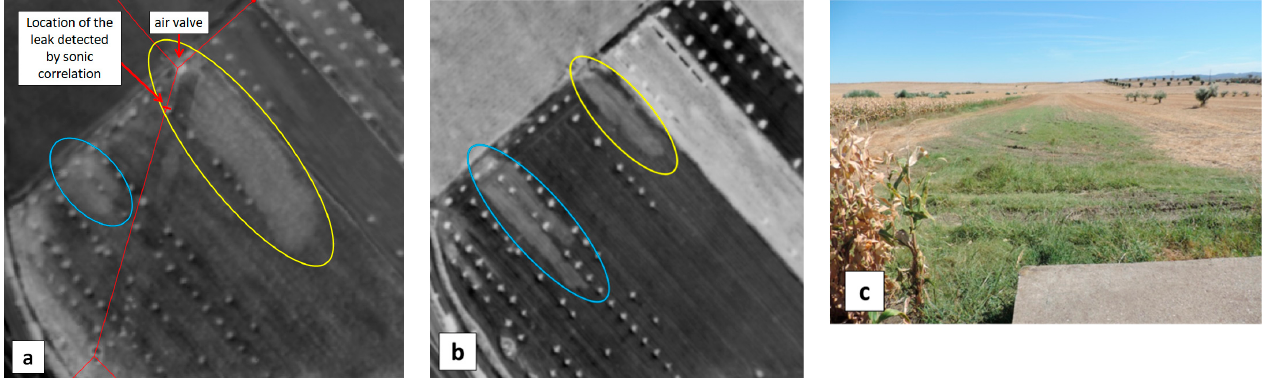
Figure 17. Excerpts of the WI maps obtained with the MAV ( a ) on 16 May 2019, ( b ) on 11 September 2019 in the vicinity of a real leak previously detected by sonic correlation, 26 m south of air valve VS13.1VS9. ( c ) Picture taken on 10 September 2019 from the air valve, in the southeast direction; the WI anomaly in the yellow ellipse in ( b ) corresponds to the green grass area extending downhill from the air valve (located in the concrete block in the foreground). (Figure 18).